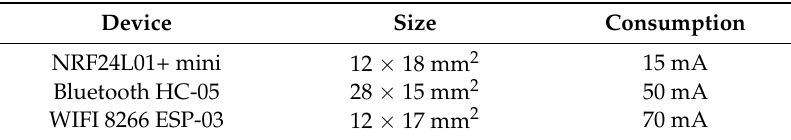
Table 2. Communication technologies comparative.